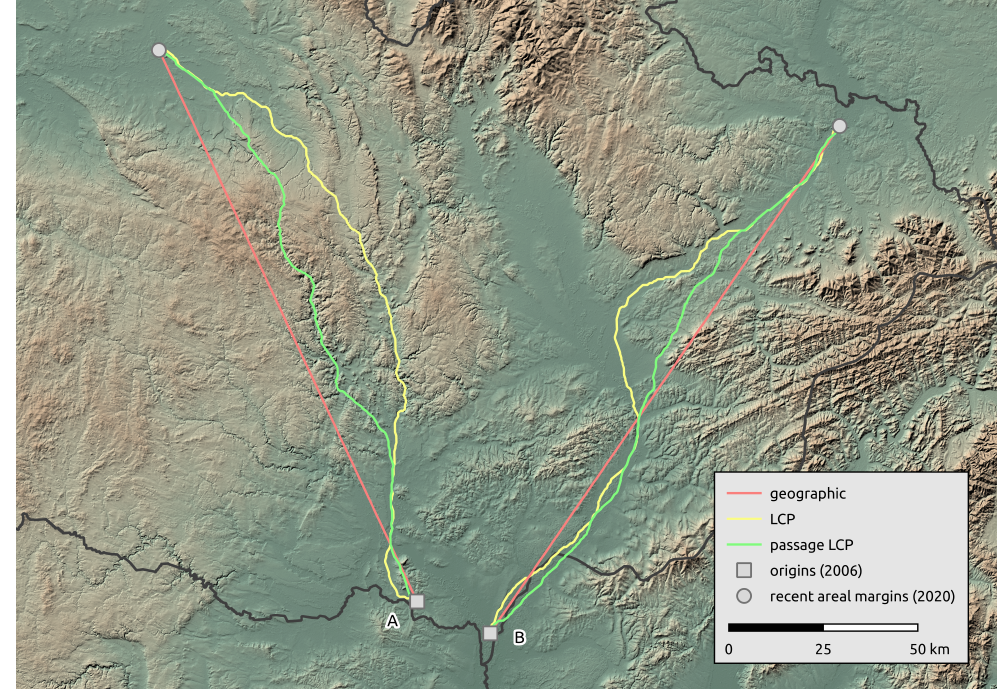
Figure 5. Comparison of R. nitidula spread paths from the two origin occurrences (2006) to the two most distant occurrences at the areal margin (2020) as calculated with three methods for estimating distance (geographic, LCP, and passage LCP).